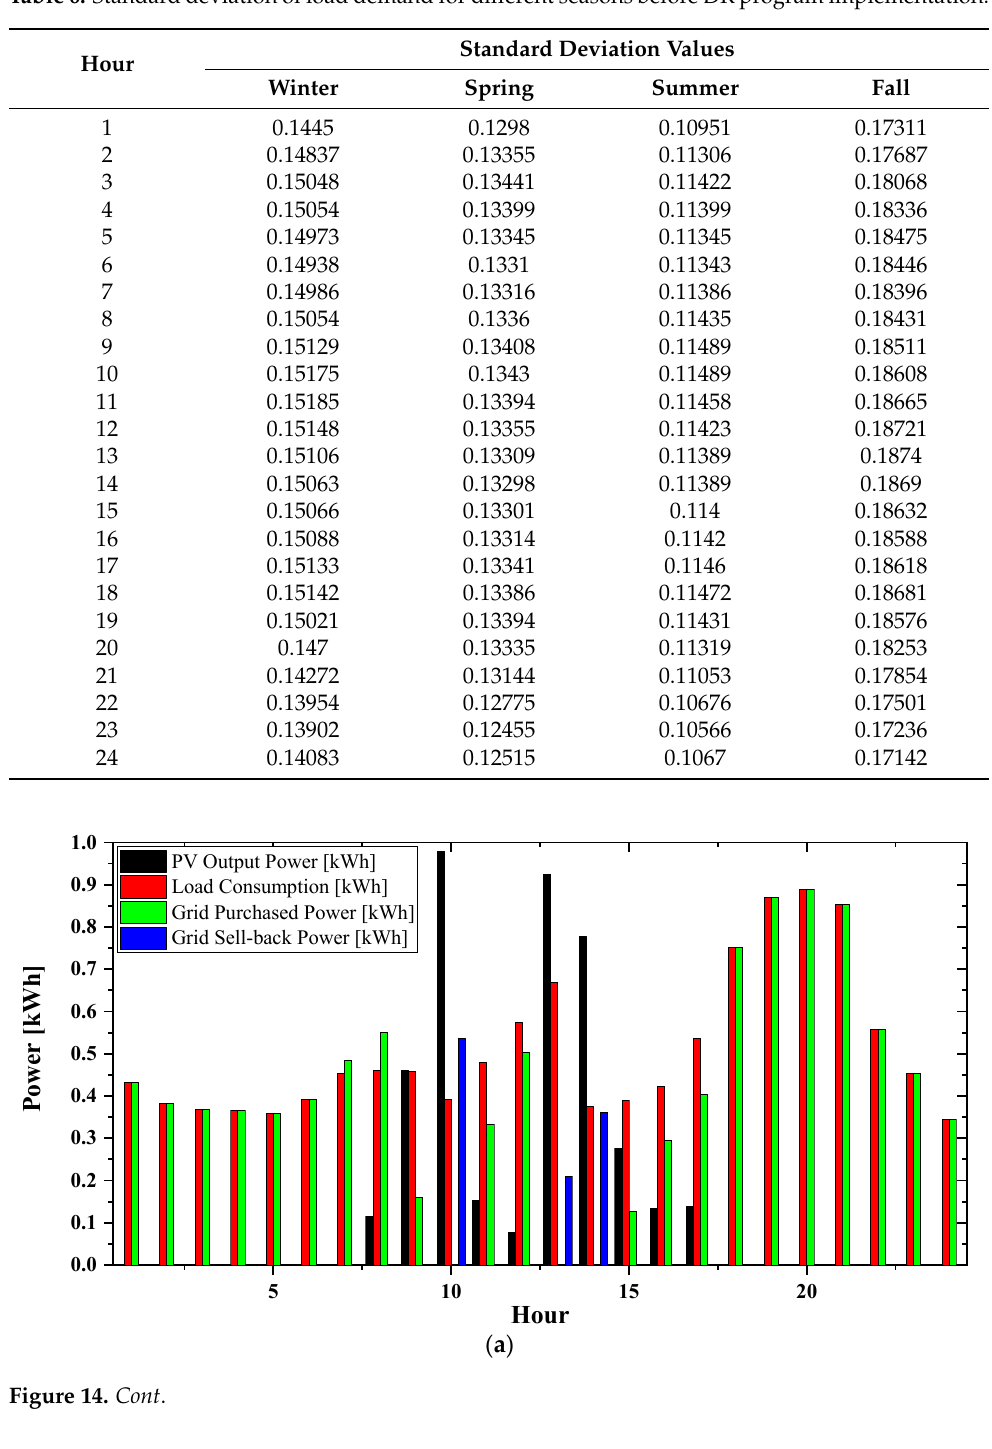
Table 6. Standard deviation of load demand for different seasons before DR program implementa- tion.